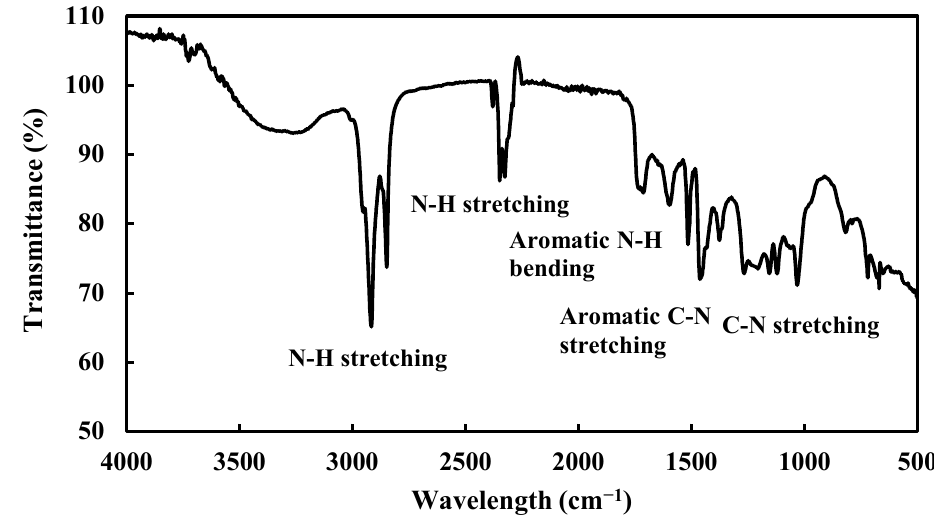
Figure 2. FTIR spectra of alkaloids extract of RR.